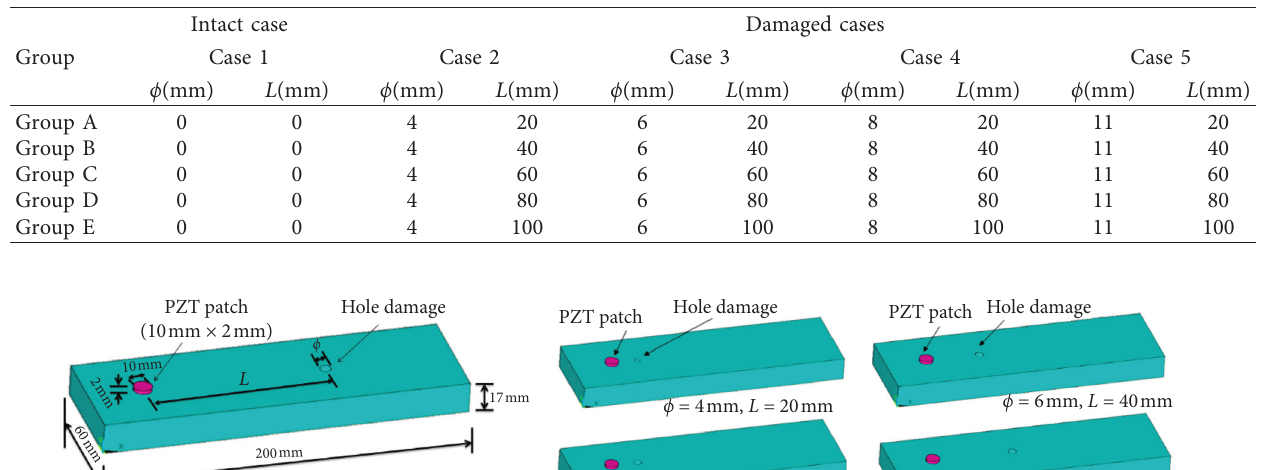
Table 1: Test cases of timber damage in Groups A, B, C, D, and E.